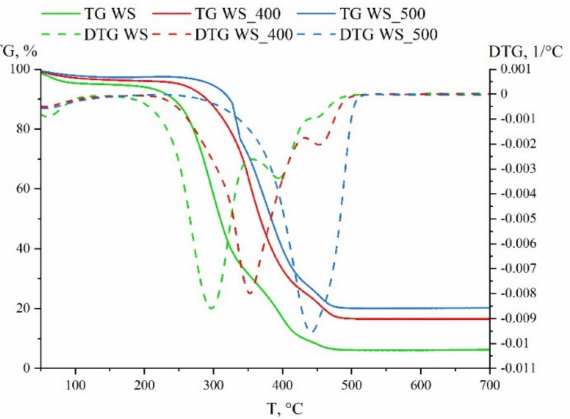
Figure 2. Thermal behaviour (TG and DTG curves) of wheat straw (WS) and biochars (WS_400 and WS_500) in an air atmosphere (combustion